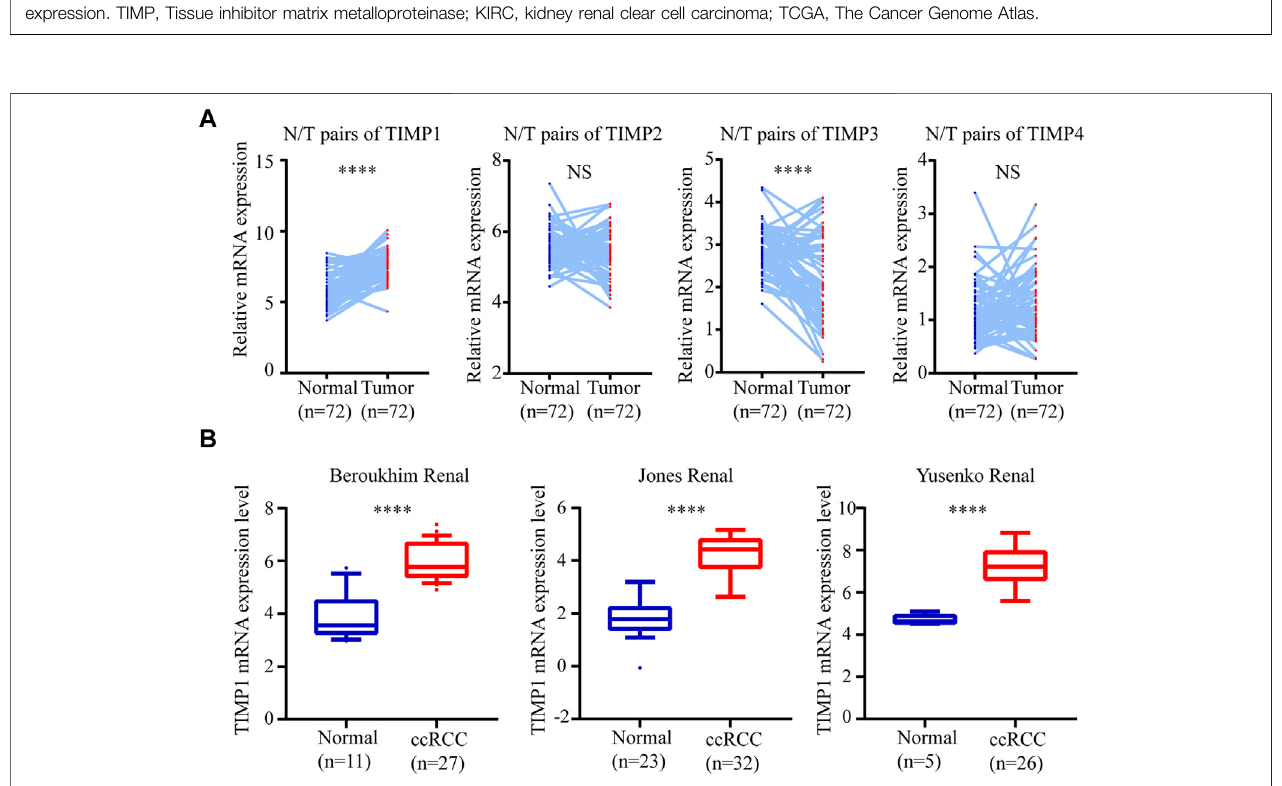
Frontiers in Genetics |